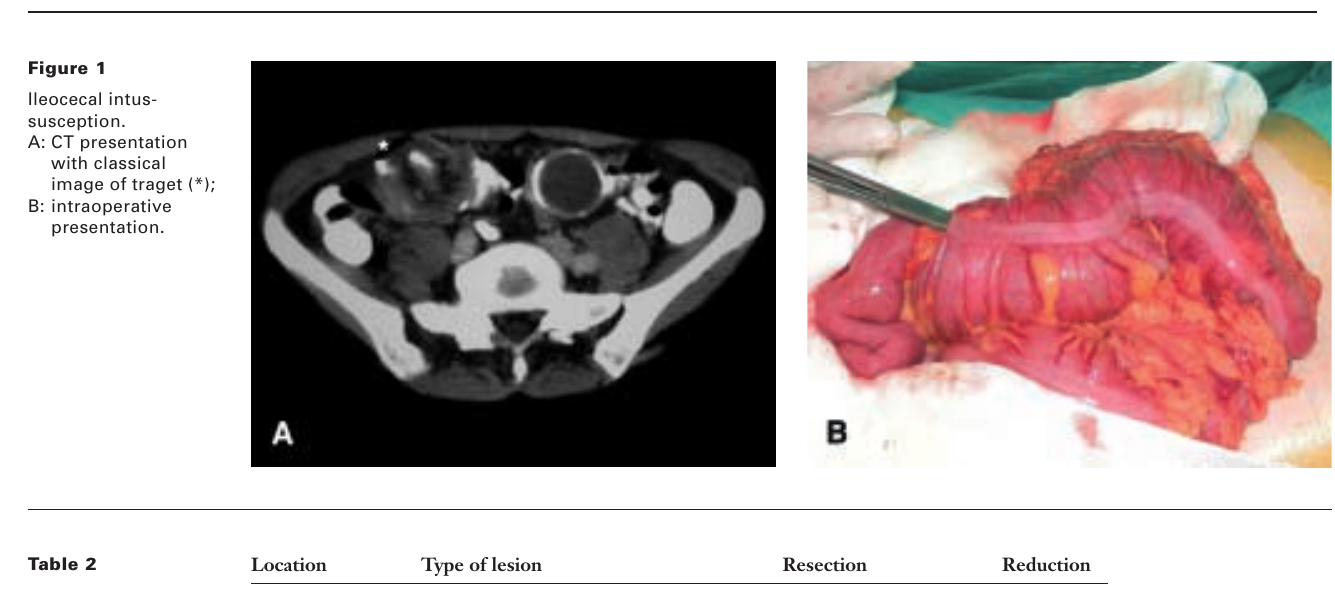
Surgical and pathological